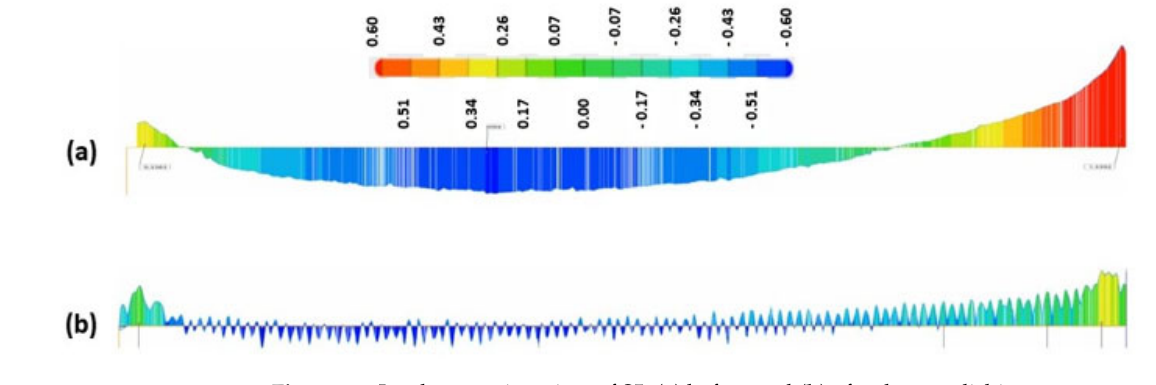
Figure 12. In ‐ plane section view of S5; ( a ) before and ( b ) after laser polishing. Error! Reference source not found. and Error! Reference source not found. show a comparison of the geometrical profile on polished and original surfaces. In the case of S1,